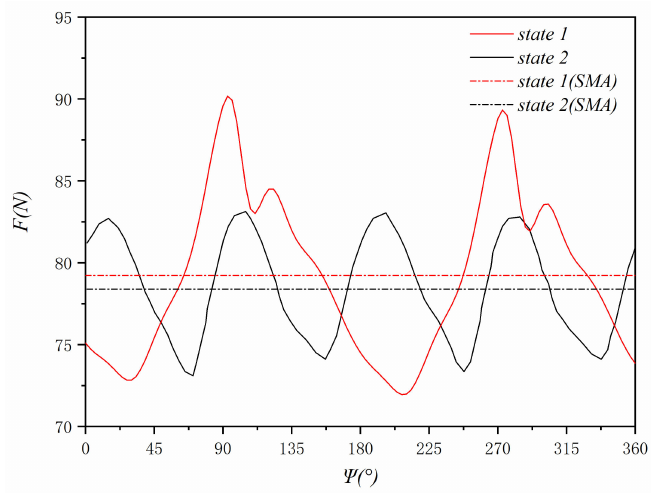
Figure 22. The lift on the wing in